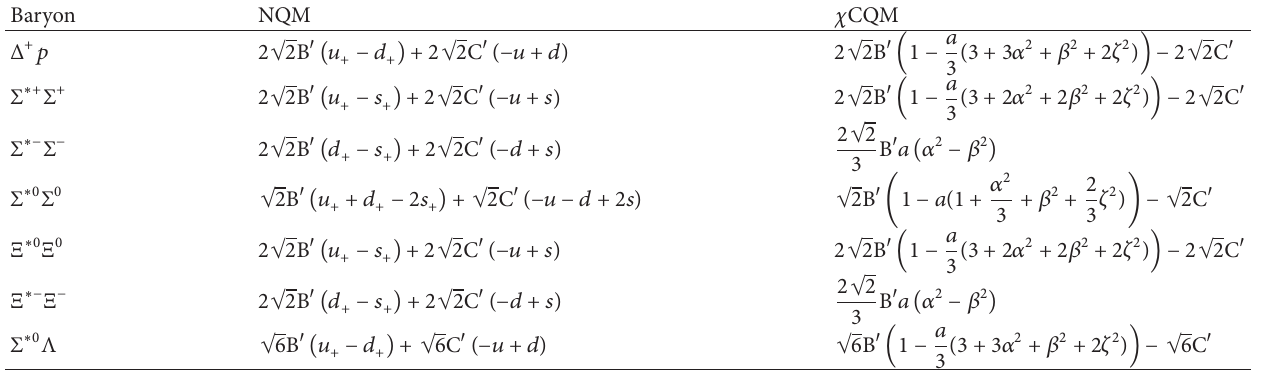
Table 9: Quadrupole moments of the spin (3/2) + → (1/2) + transitions in NQM and 𝜒 CQM using the